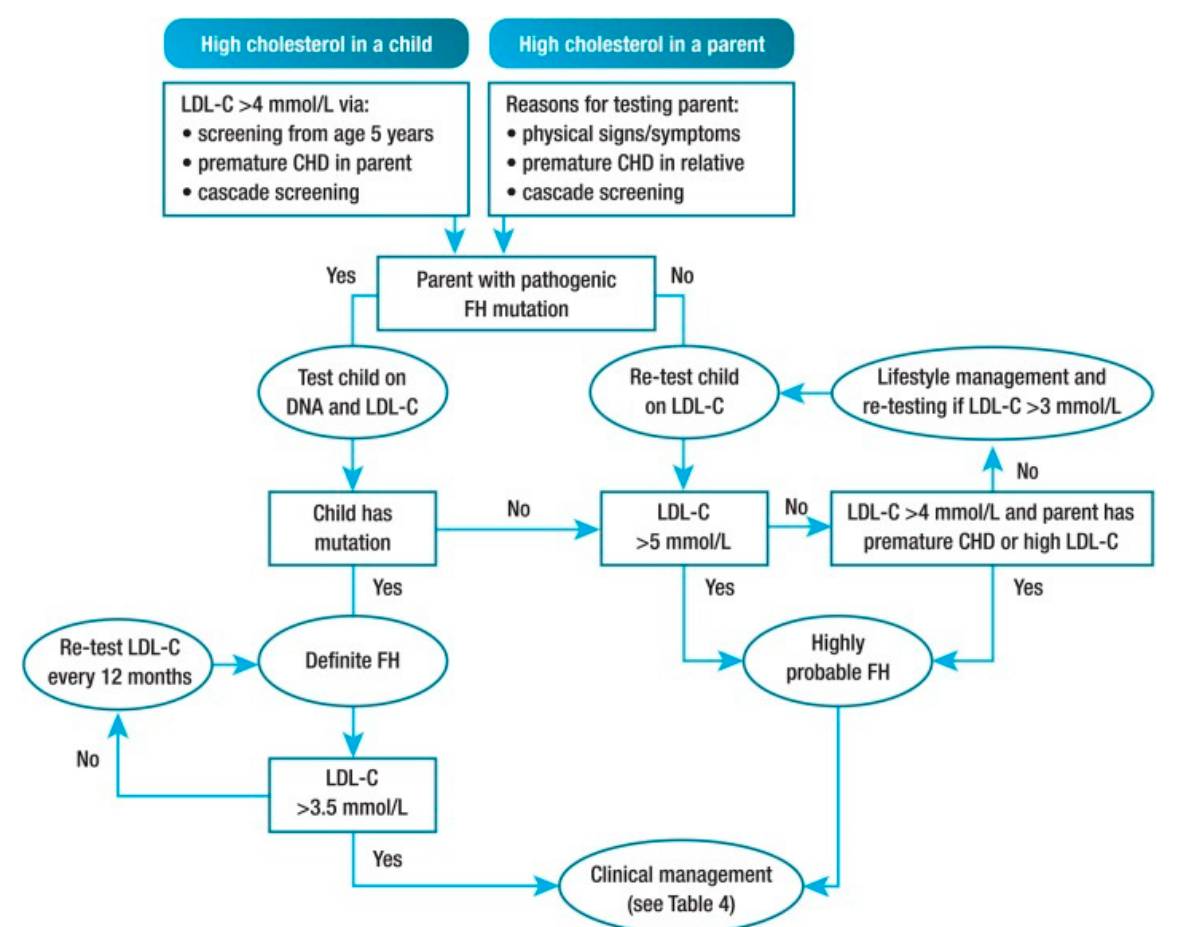
Figure 3. Potential strategy for diagnosis of FH in children and adolescents. CHD, coronary heart disease; FH, familial hypercholesterolemia; LDL-C, low-density lipoprotein cholesterol. Definitions: premature CHD is defined as a coronary event before age 55 years in men and age 60 years in women. Definite FH is defined as genetic confirmation of at least one FH-causing genetic variant. Close relative is defined as 1st or 2nd degree. Highly probable FH is based on clinical presentation (i.e., phenotypic FH), either an elevated LDL-c level ≥ 5 mmol/L in a child after dietary intervention or an LDL-c level ≥ 4 mmol/L in a child with a family history of premature CHD in close relatives and/or baseline high cholesterol in one parent. Cascade screening from an index case with an FH-causing variant may identify a child with elevated LDL-c levels ≥ 3.5 mmol/L [9].